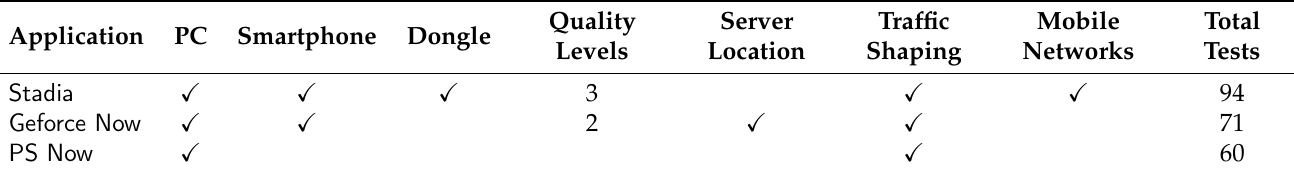
Table 1. Overview of the measurement